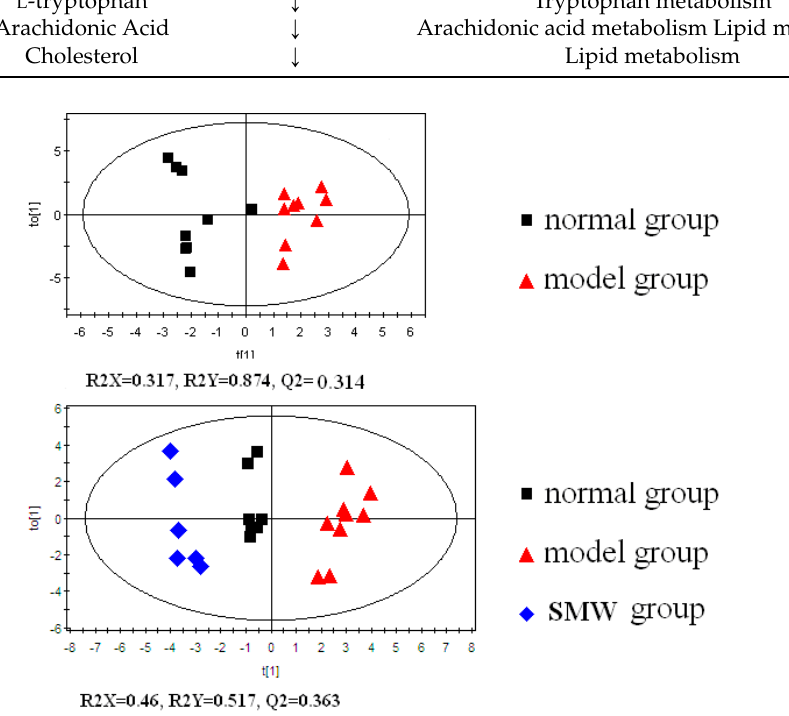
Figure 2. The score plot from the orthogonal partial least-square discriminant analysis (OPLS-DA) of the GC-MS data obtained from the plasma samples of normal rat, rheumatoid arthritis (RA) rats, and SMW-treated rat.